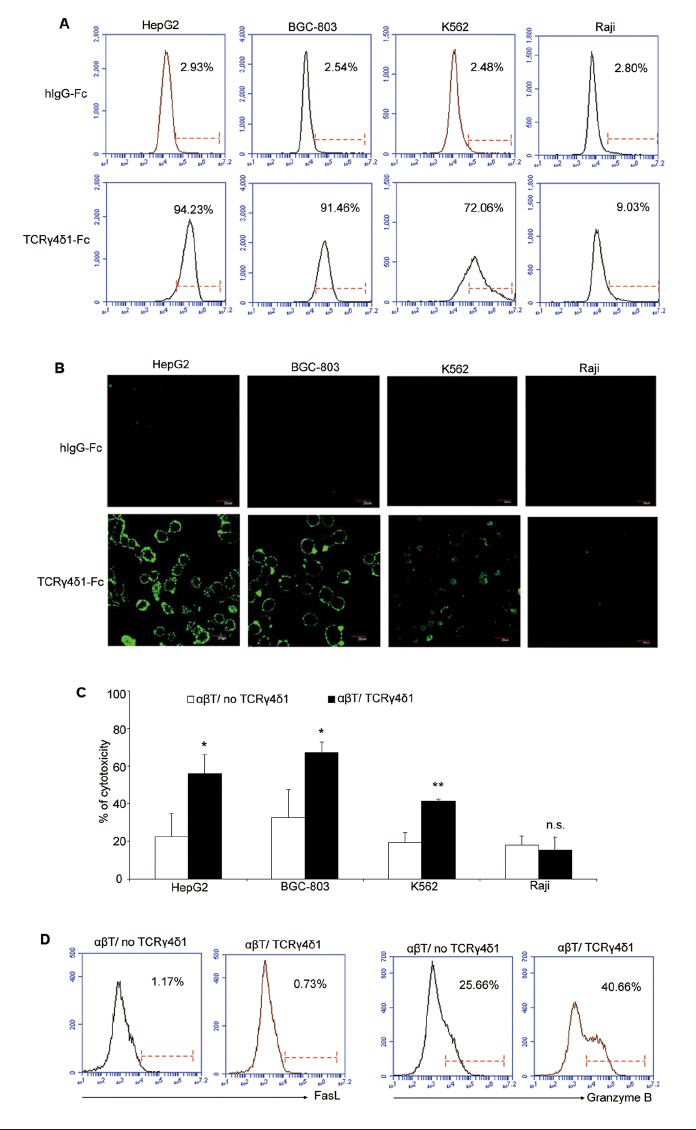
Figure 2. Cytotoxicity of TCR g 4 d 1 -engineered αβ T cells to tumor cells in vitro. (A) Flow cytometry profiles of the binding of TCR γ 4 δ 1-Fc fusion protein to the tumor cell lines HepG2, BGC-803, K562 and Raji. After incubation with TCR γ 4 δ 1-Fc, tested cells were stained